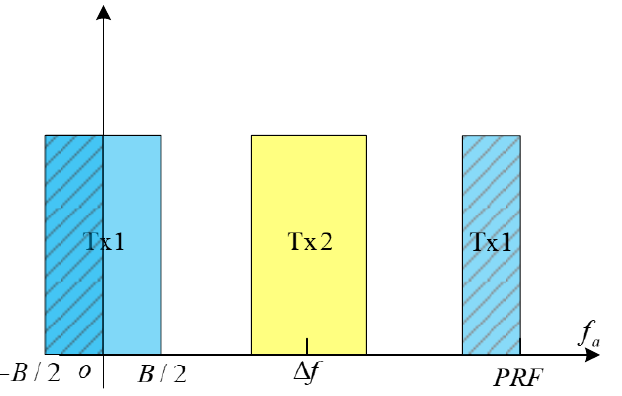
Figure A1. Diagram of the different channel data.